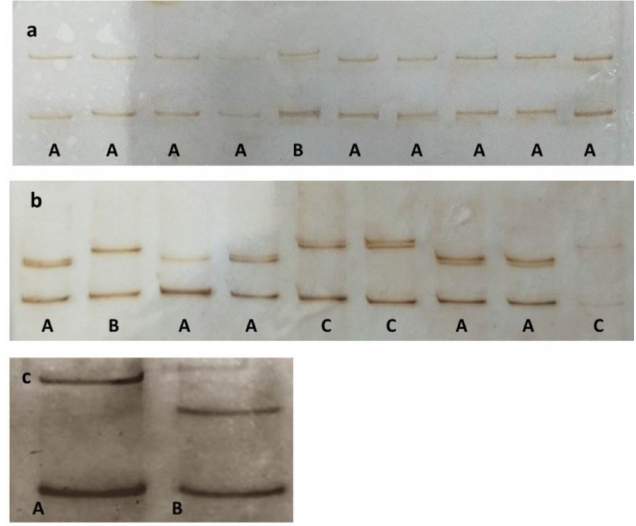
Figure 5. An example of different GLRaV-3-HSP70h haplotypes (marked with letters A, B, C) identified by single-strand conformation polymorphism (SSCP) in monophyletic isolate infecting plants of cv Pošip Bijeli 5 ( a ) and polyphyletic GLRaV-3 isolate infecting plant of cv Vugava 7 ( b ). Different SSCP patterns of variants belonging to group I and II are shown in ( c